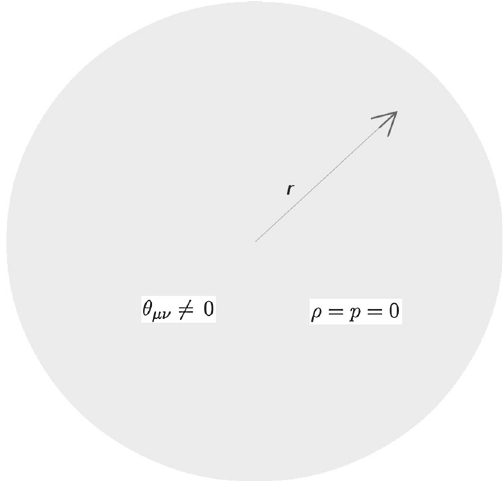
Fig. 1 Spherically symmetric source θ μν in the vacuum ρ = p =